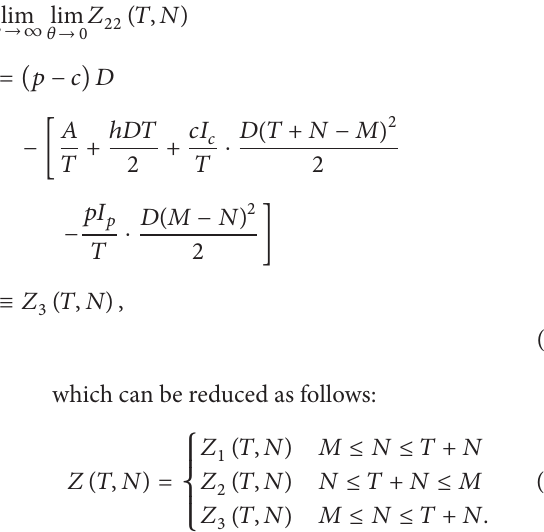
Figure 11: Optimal total average profit w.r.t. downstream credit period length of the first type